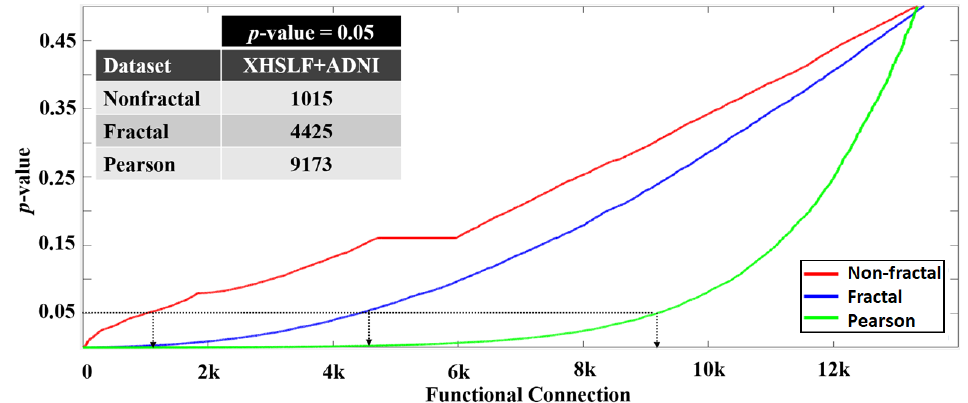
Figure 8. Plot of p -value of 13,456 connections of dataset XHSLF+ADNI arranged in increasing order for the nonfractal, fractal and Pearson correlation. The number of significant connections, obtained at p = 0.05, for each connectivity measure is listed in the inset table.